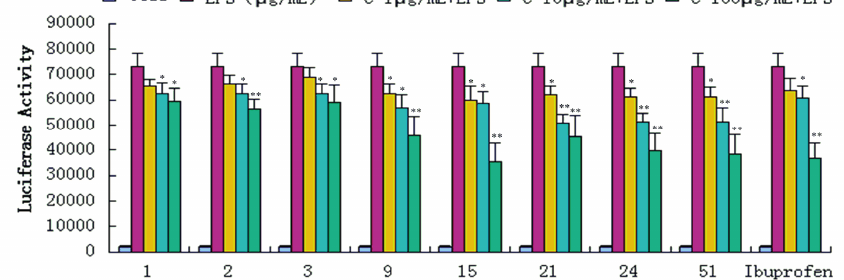
Figure 4. Inhibitory effects of compounds 1 , 2 , 3 , 9 , 15 , 21 , 24 and 51 (1, 10, 100 μ